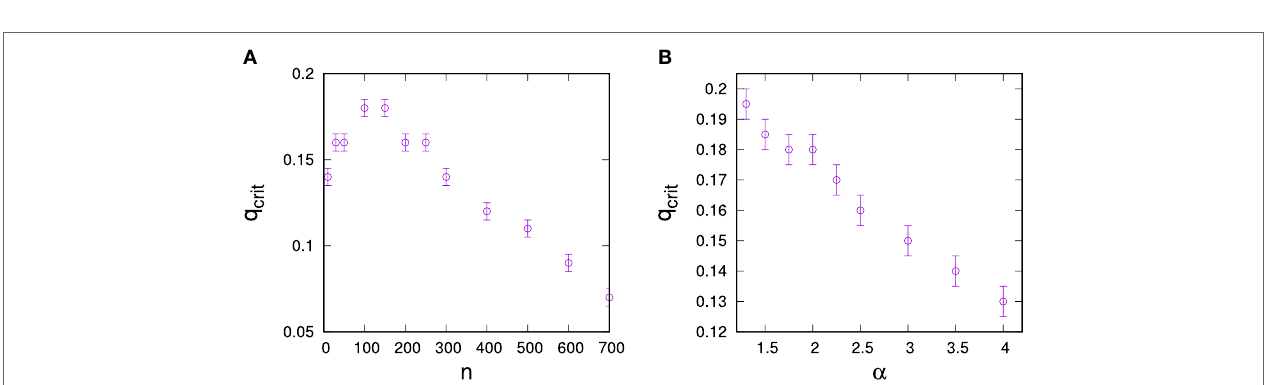
FIGURE 4 | Dependence of the critical predisposition strength at which optimal control switches from hub control to low-degree control on (A) the total resource endowment of the controller n , (B) network heterogeneity for resource endowment n = 10 for the controller. The data are for networks of N = 1,000 with connectivity ⟨ k ⟩ = 3 and error bars result from the discretization of q-values when constructing (cid:27) k ,controlled( q ) plots.